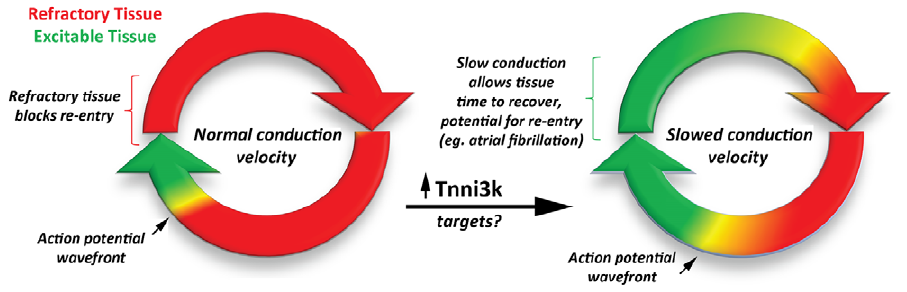
Figure 1. The development of a reentry circuit due to slowed action potential velocity. Increased expression of Tnni3k (and downstream targets) slows conduction velocity of the propagating action potential. Slowed conduction, in turn, favors the formation of stable reentrant propagation, a common mechanism for sustained arrhythmia.